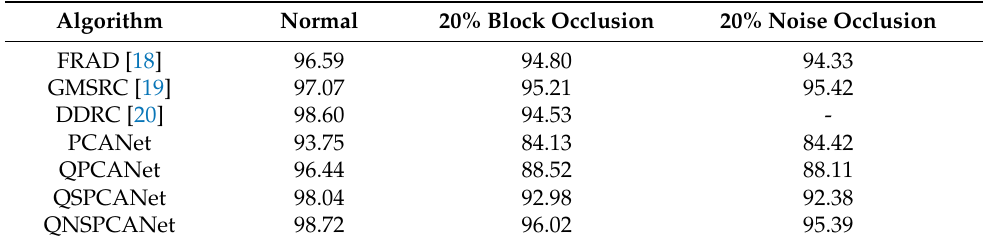
Table 2. The correct recognition rate of each algorithm in Color FERET dataset under different occlusion conditions (%).